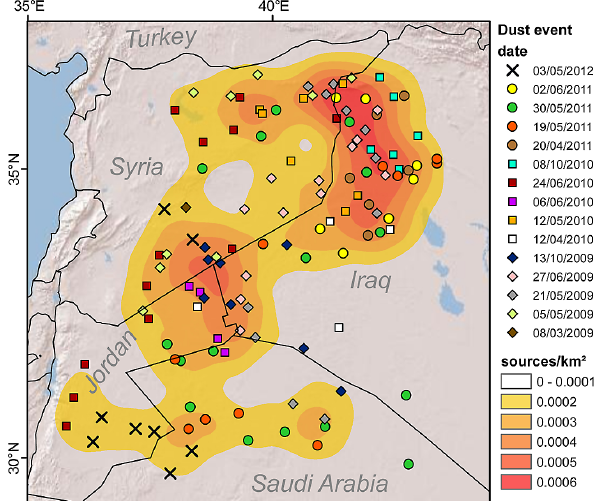
Fig. 4. The Middle Eastern source regions of dust transported